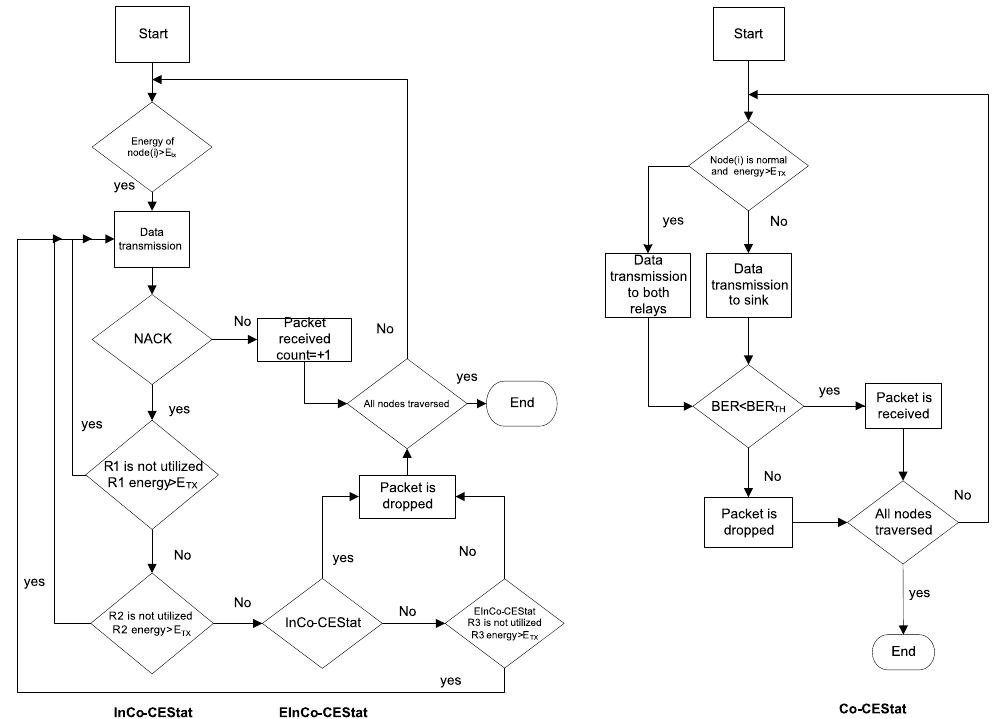
Figure 5. Communication flow diagram of InCo-CEStat, EInCo-CEStat and